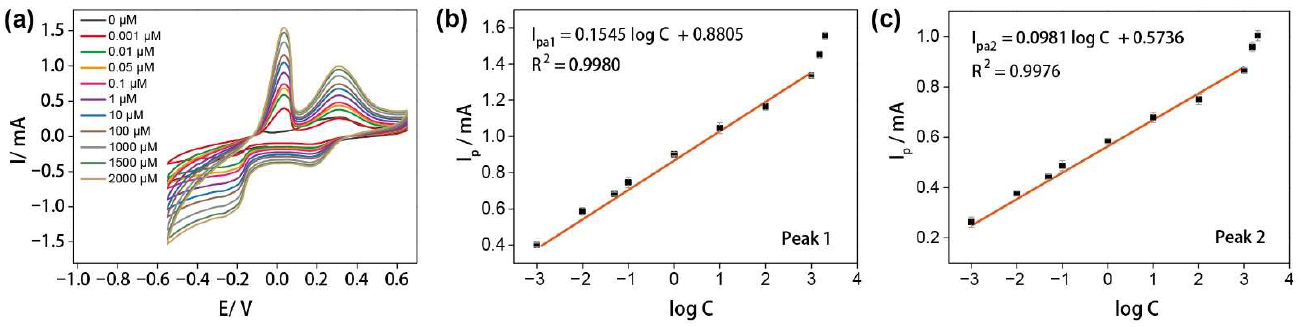
Figure 3. ( a ) Cyclic voltammograms of carbon-based electrode for the detection of the different concentrations of glutamates (0, 0.001, 0.01, 0.05, 0.1, 1, 10, 100, 1000, 1500, and 2000 μM) in 10 mM PBS containing 4 mM CuCl 2 ; ( b ) calibration curve of I p vs. log C of anodic peak 1; ( c ) calibration curve of I p vs. log C of anodic peak 2.